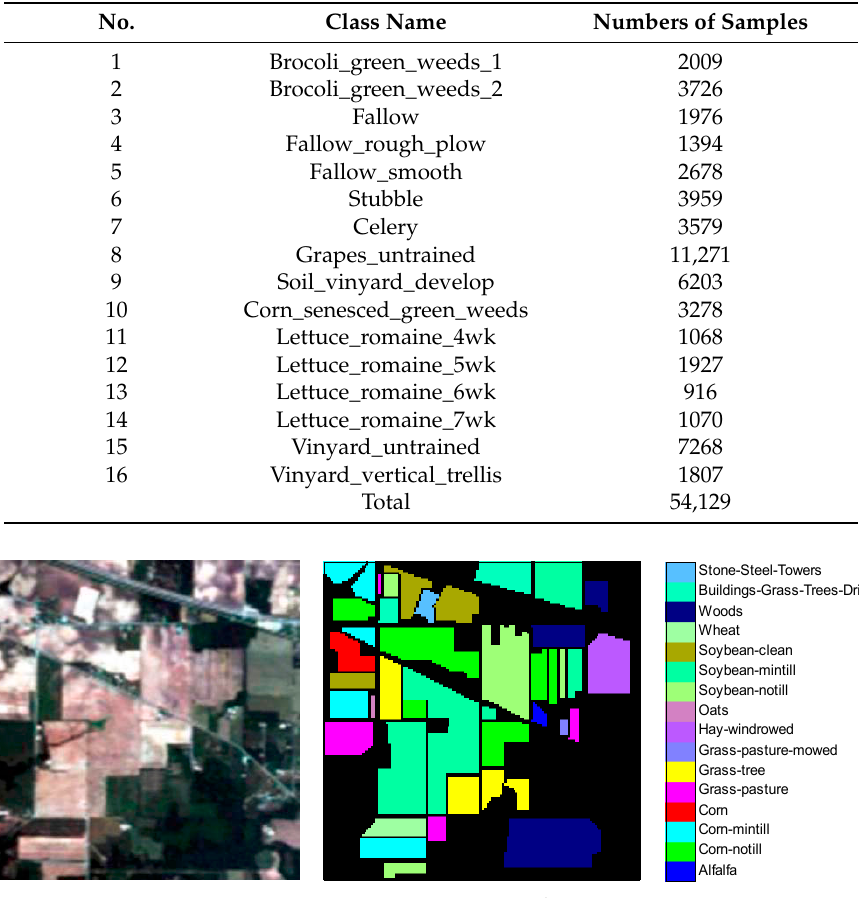
Table 1. Land cover classes and numbers of samples in the Indian Pines data set. Table 4. Land cover classes and numbers of samples in the Salinas data set.